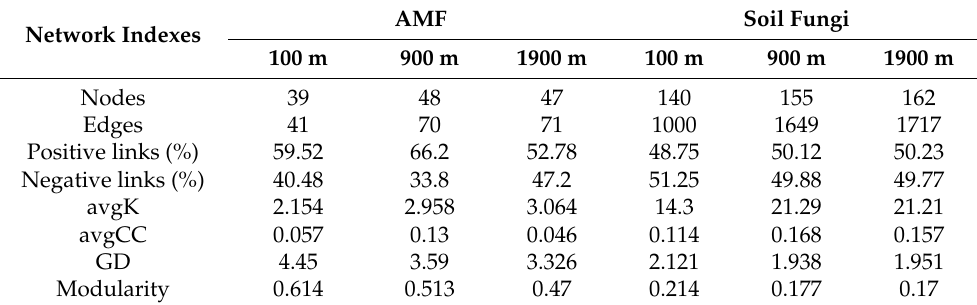
Figure 4. Networks of soil AMF and fungal communities. The nodes are colored according to the taxonomic information at genus (AMF) and family (soil fungi) level. Lines connecting nodes represent positive (red) or negative (green) co-occurrence relationships. ( A ): network of soil AMF at 100 m; ( B ): network of soil AMF at 900 m; ( C ): network of soil AMF at 1900 m; ( D ): network of soil fungi at 100 m; ( E ): network of soil fungi at 900 m; ( F ): network of soil fungi at 1900 m. Table 2. The topological property parameters of networks.